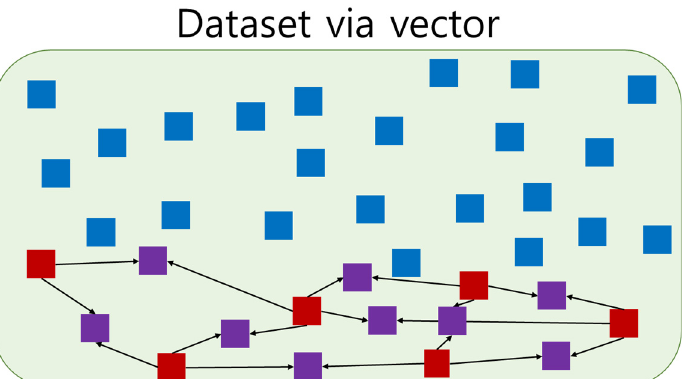
Figure 6. Example of Synthetic Minority Oversampling Technique. Blue is majority data, red is minority data, and purple is the generated minority data. Each generated minority data was gen- erated from two minority data.